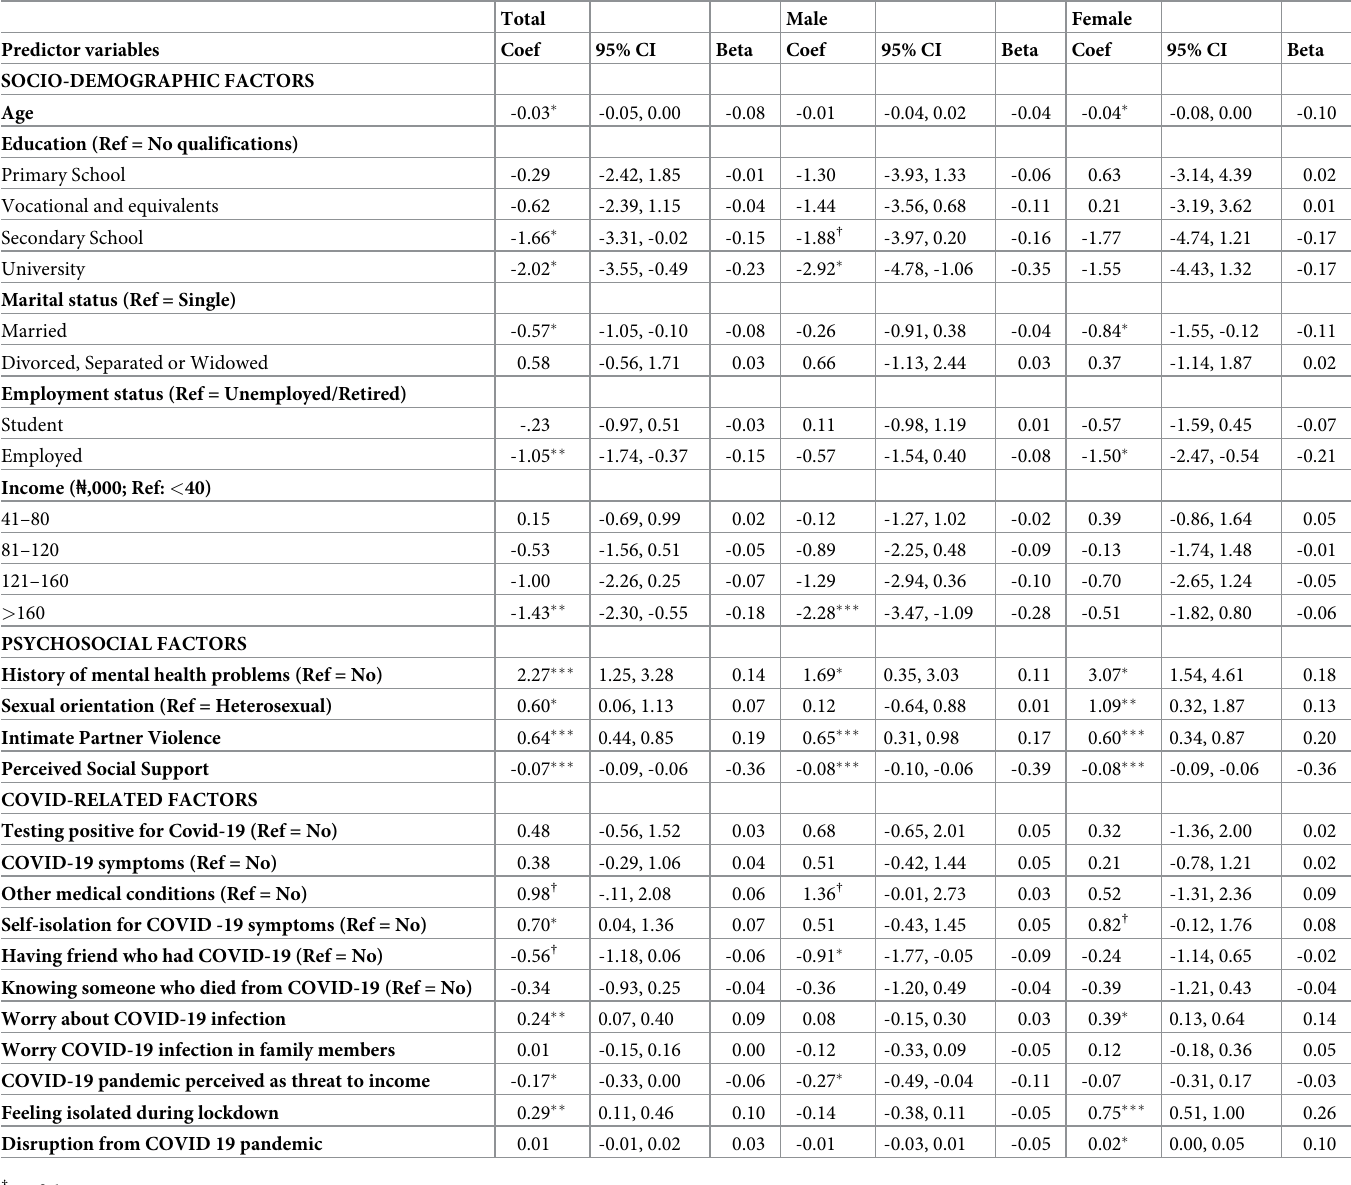
Table 3. Univariate associations between depressive symptoms and predictors with sex